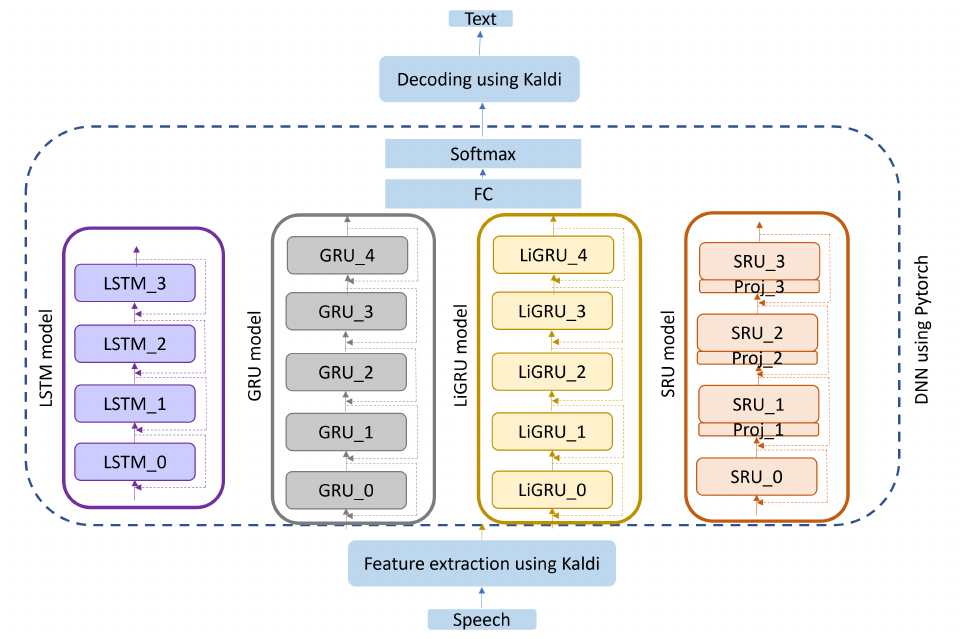
Figure 1. The ASR models using KALDI for feature extraction and decoding and RNN for speech recognition. The RNN can be a LSTM-, GRU-, LiGRU-, or SRU-based